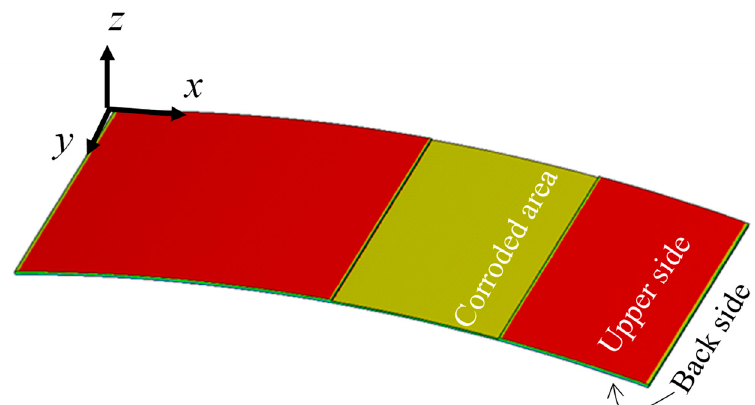
Figure 6. Analytical result with a thickness reduction of 0.2 mm. Red and yellow colors mean 581 με and 350 με in axial direction. The dimension is 95 mm in length and 45 mm in width and the corroded area is 1350 mm 2 (30 mm × 45 mm).